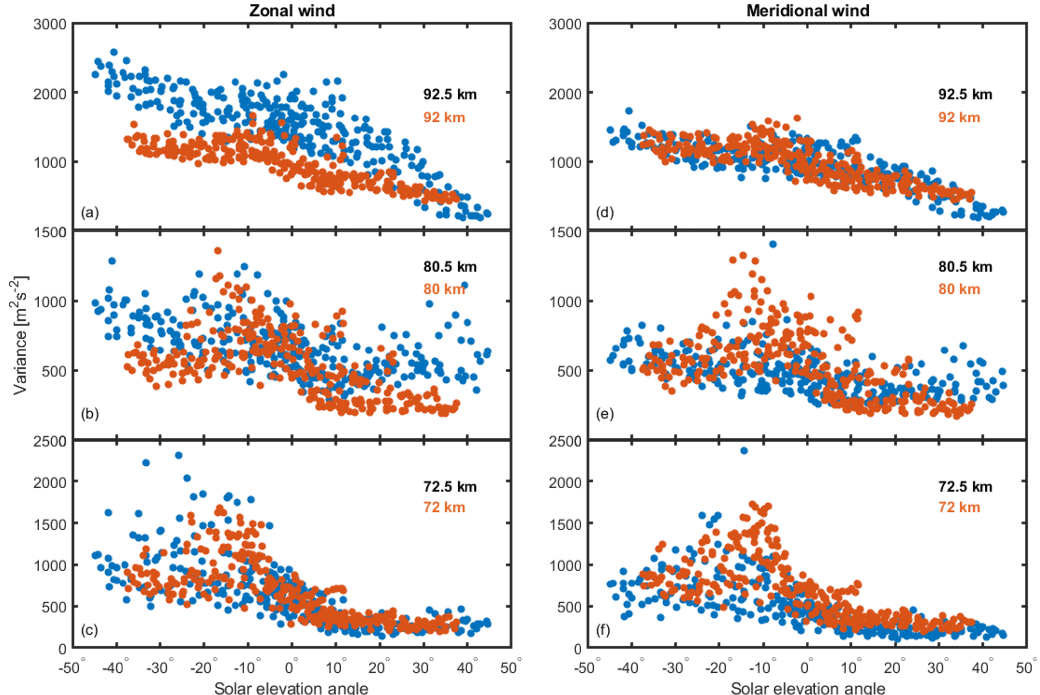
Figure 8. Zonal (a–c) and meridional (d–f) wind variance from the Rothera (blue) and Halley (orange) radar for three altitudes as a function of solar elevation